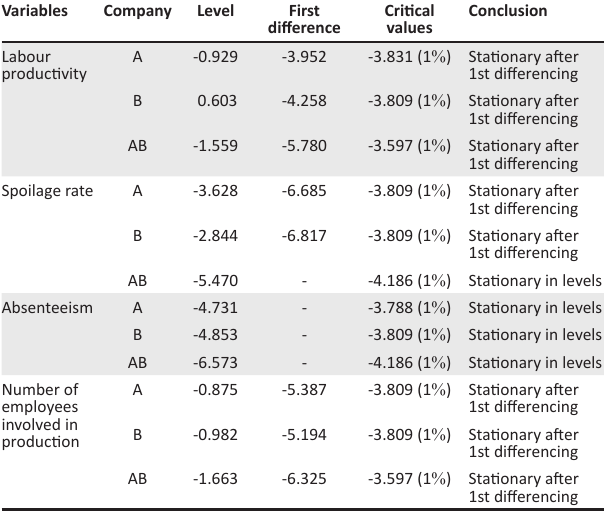
TABLE 2: Augmented Dickey–Fuller stationarity test